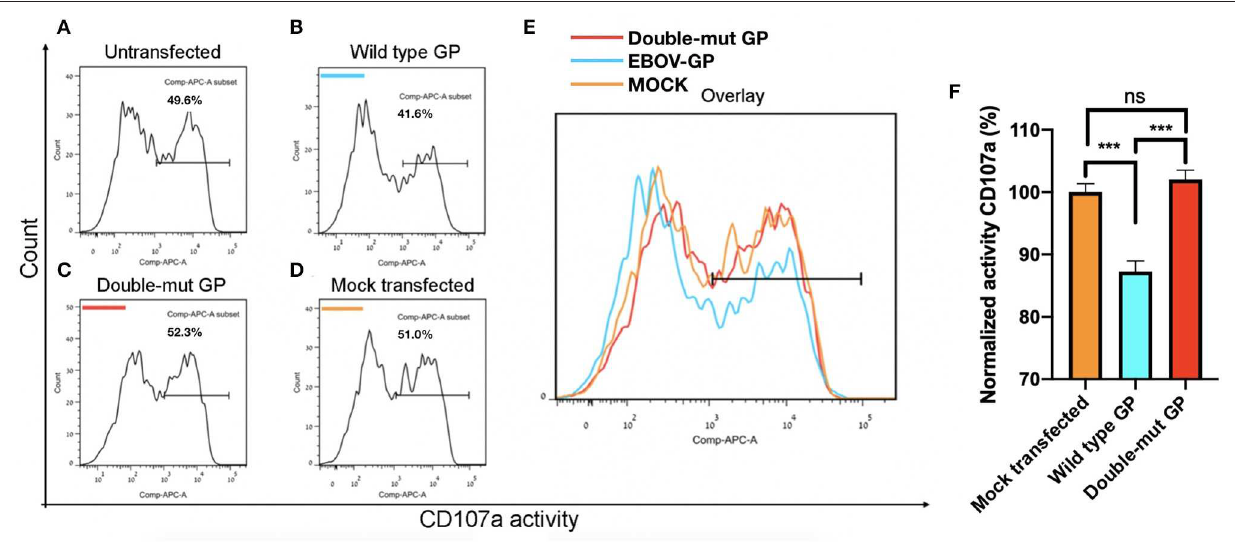
FIGURE 3 | Site-specific mutations, disrupting the N-linked glycosylations in GP, result in the restoration of pNK degranulation. HEK293T cells were either left untransfected (A) or transfected with wild-type GP (B) , GP glycan deletion mutants (C) , or mock vector (D), and cocultured with pNK cells in the presence of 25 U/ml rhIL2 ( Edri et al., 2018). Effector cells were sampled and assayed for natural killer cell degranulation marker CD107a. (E) Plot shows overlay of CD107a stains of pNK cells cultured with the different target cells. (F) Summary plot shows degranulation level of pNK cells cultured with different target cells. Results are from two representative experiments of four replications. Graphs representing mean ± SEM. *** p < 0.001, Ordinary one-way ANOVA multiple comparisons